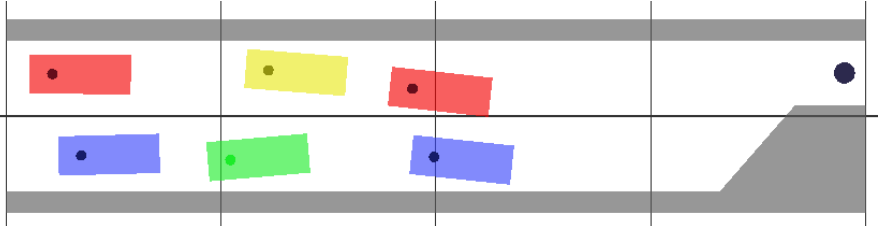
Figure 5. The zipper scenario with the narrowing located on the left side of the road. All the agents share the same goal marked as a dark blue dot on the right side of the image.